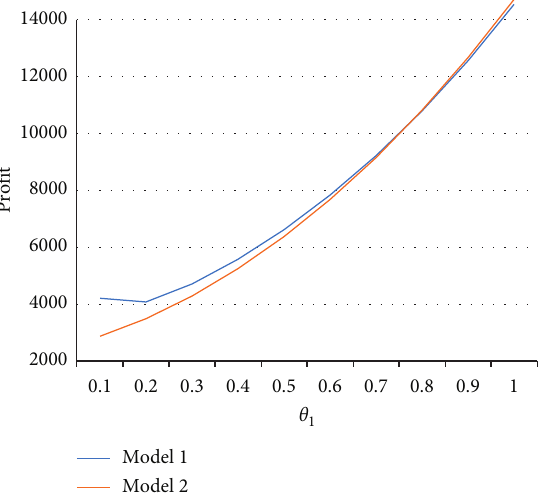
Figure 5: The impact of θ